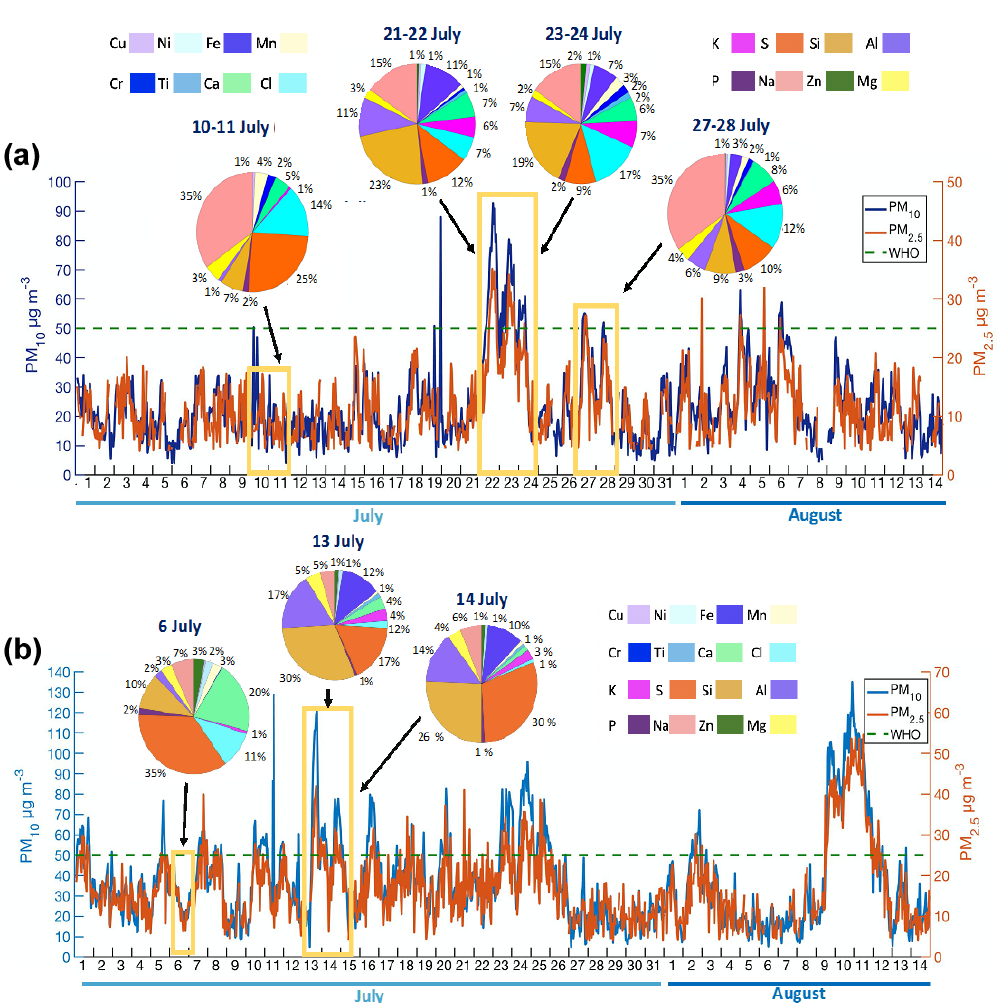
Figure 2. Mass concentrations of PM 2 . 5 and PM 10 in (a) 2017 and (b) in 2018. The green horizontal line depicts the World Health Organiza- tion air quality guideline for 24h mean PM 2 . 5 (right y axis) and PM 10 (left y axis) concentrations of 25 and 50µgm − 3 , respectively (WHO, 2002). The pie charts represent the elemental composition from the XRF for the African dust peaks